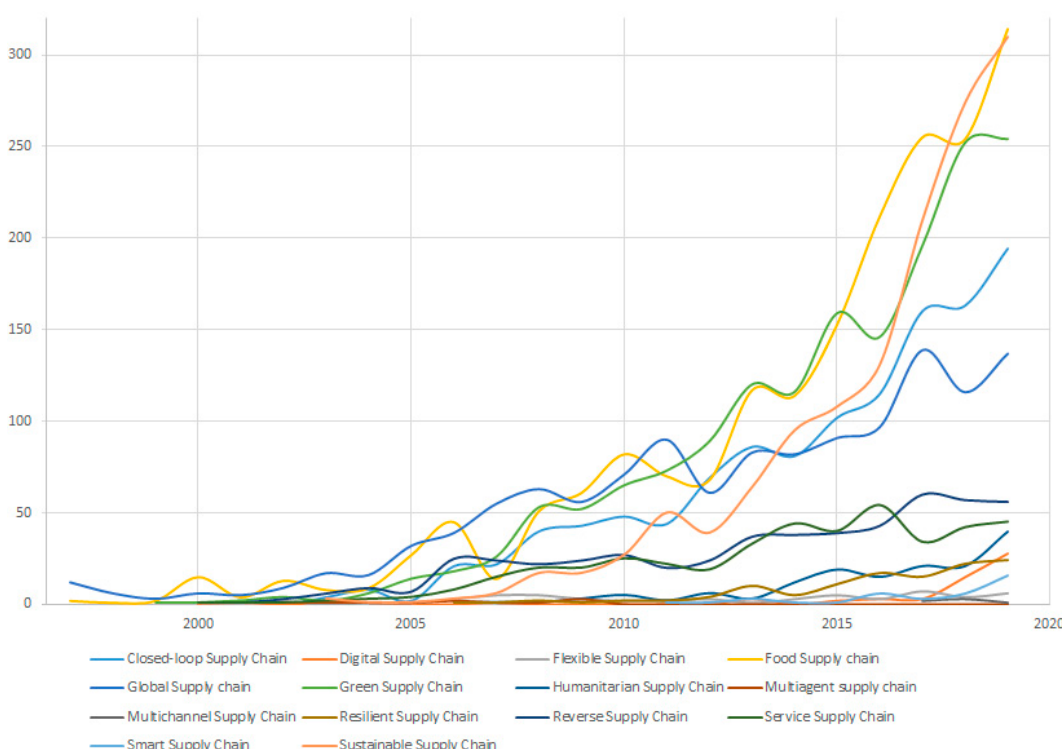
Figure 7. Supply chain trends (data including full trend names); own elaboration based on the conducted research.